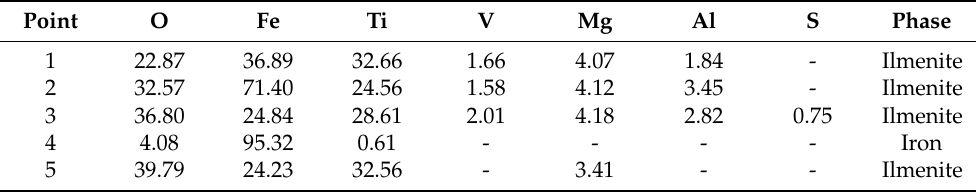
Table 3. Elemental composition of points shown in Figure 4